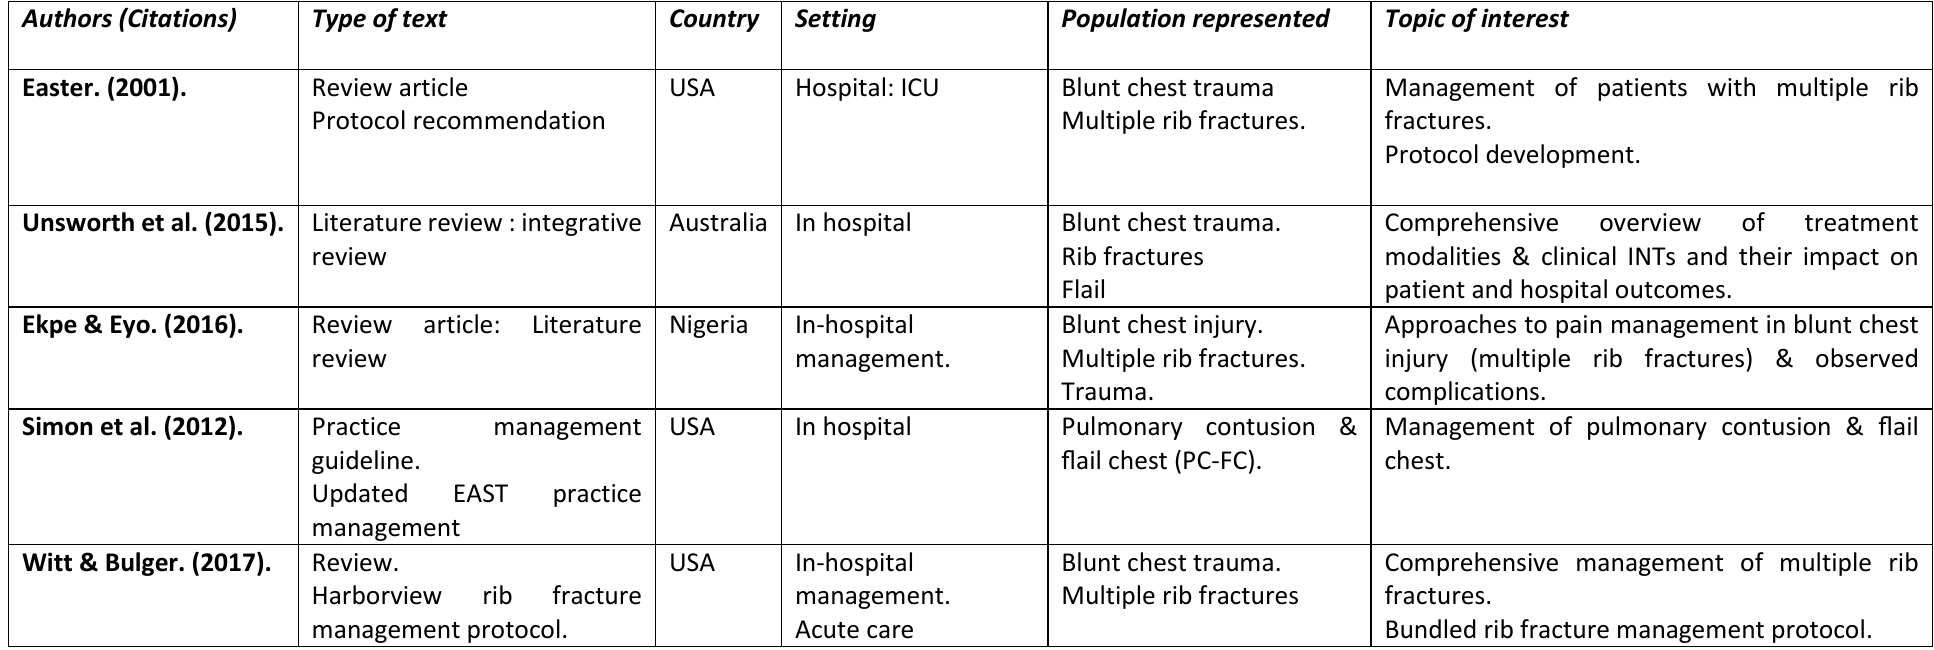
TABLE 11-A1: Baseline characteristics of Included Text & Opinion